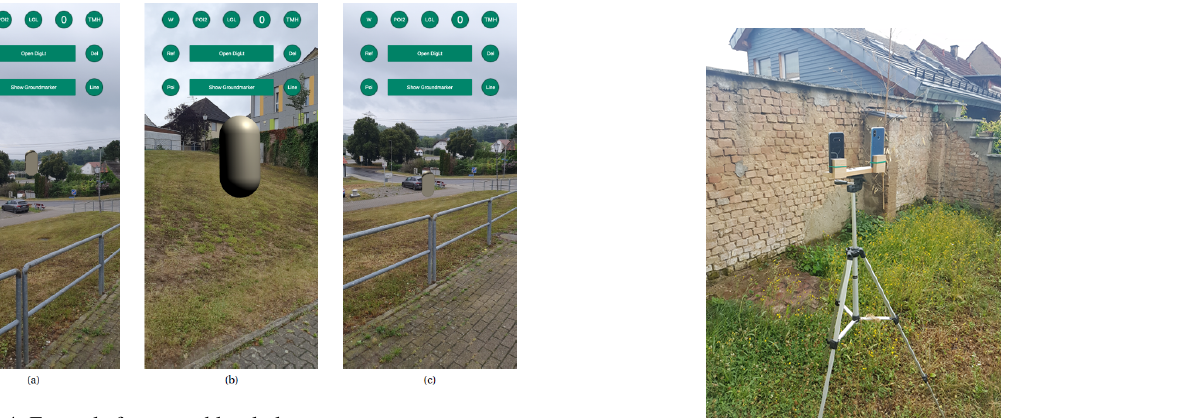
Figure 4. Example for ground level placement